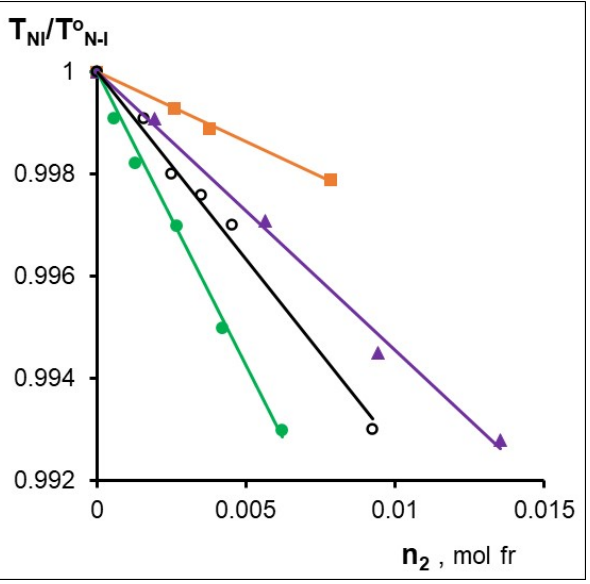
Figure 3. Fragments of phase diagrams for the CB-2 mixtures with - ○ - MADMECl; - ▲ -Zn-MADMECl; - ■ -Cu-MADMECl; - • -Ni-MADMECl.